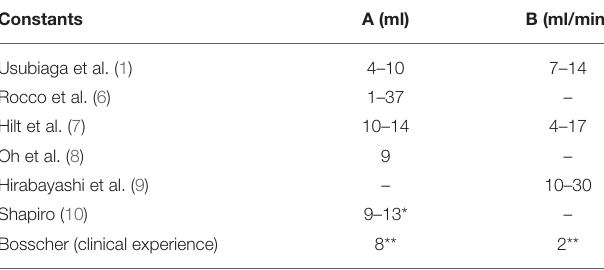
TABLE 1 | Values of A and B calculated from experimental data in the